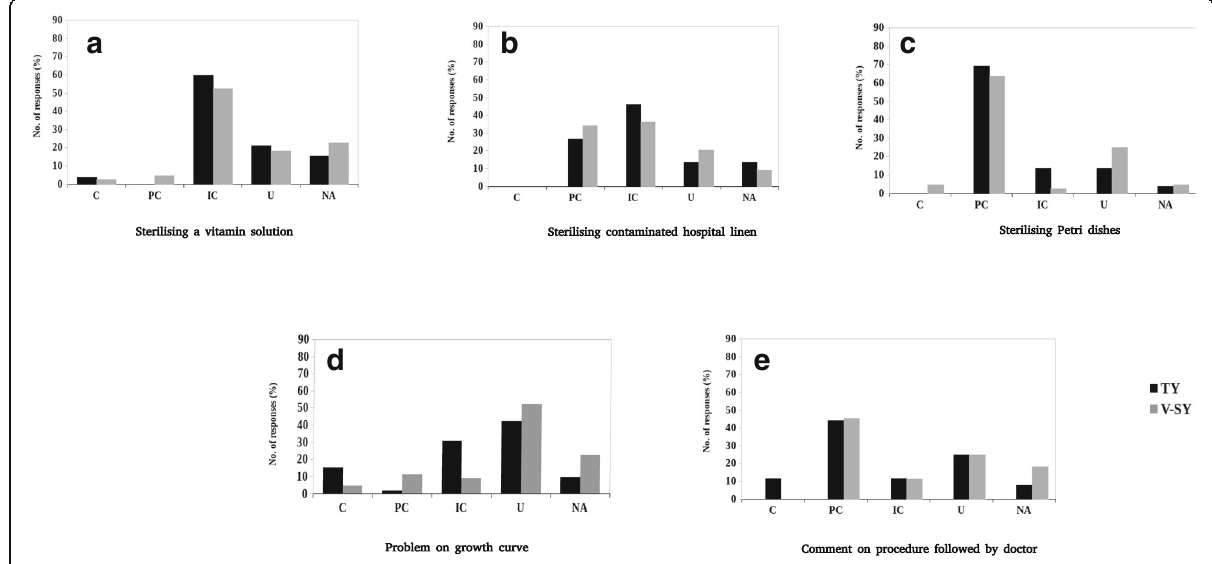
Fig. 3 Percentage of student responses in each category for the three questions identified by their keywords: a – c are subparts of the “ easy ” question. d "moderate" question, e "difficult" question. The x -axis represents categories of student responses. C Correct; PC Partially Correct; IC Incorrect; U Unrelated; NA Not Attempted; TY Third-year students from college V; V-SY Second-year students from college